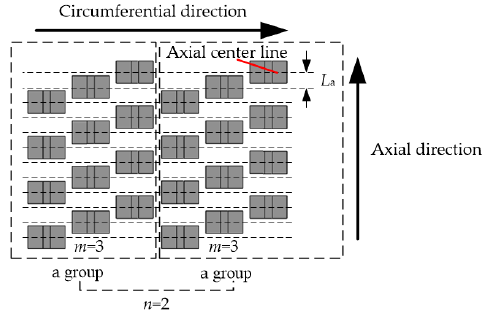
Figure 2. The circumferential outspread diagram of the secondary.